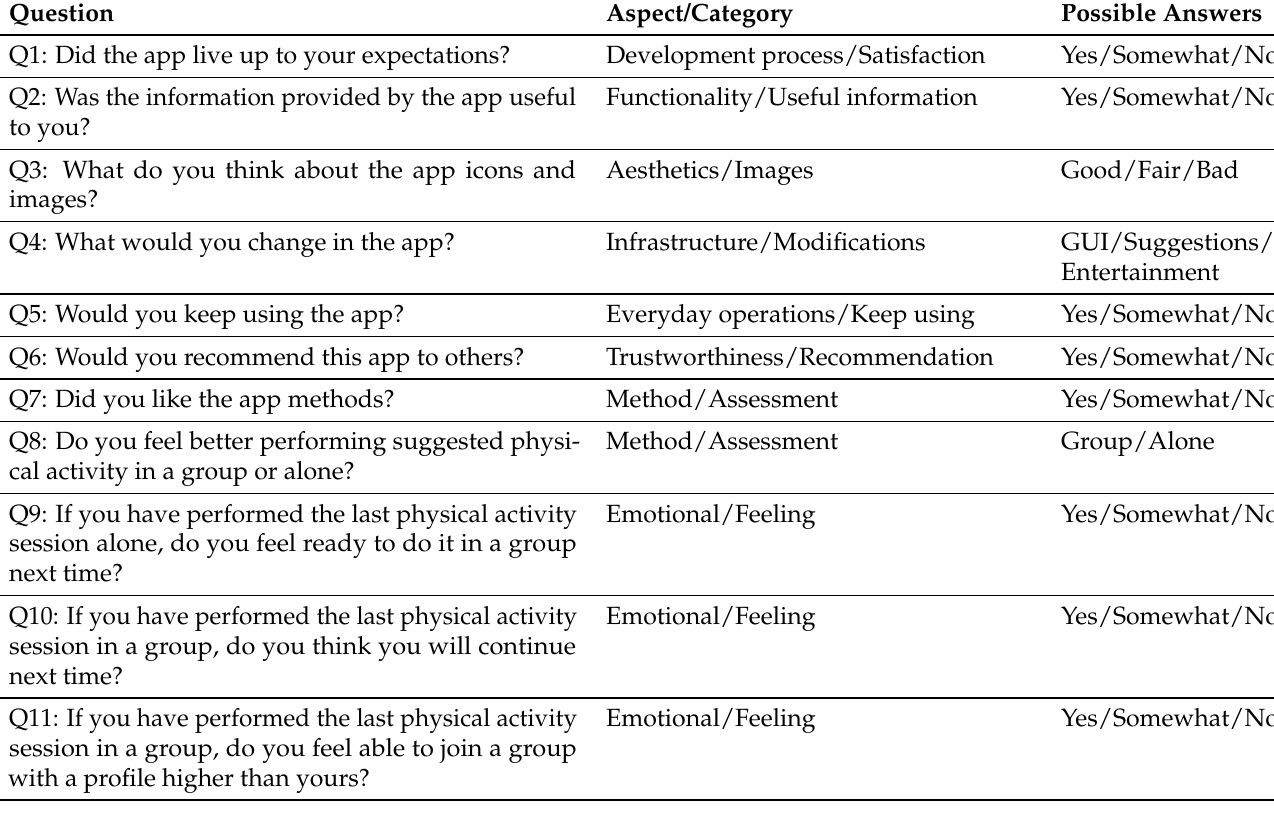
Table 3. Questionnaire for user experience evaluation inspired by [58].